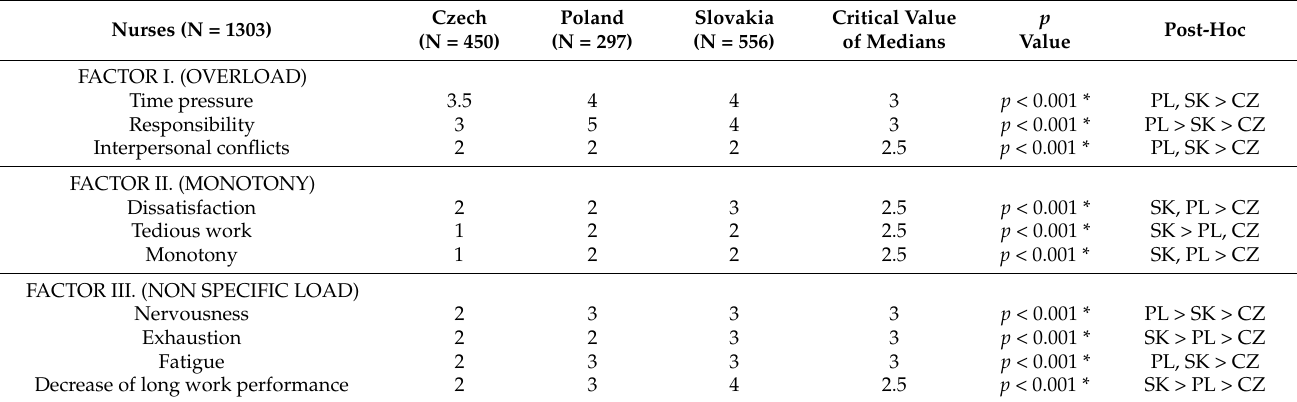
Table 4. Assessment of critical medians in nurses by